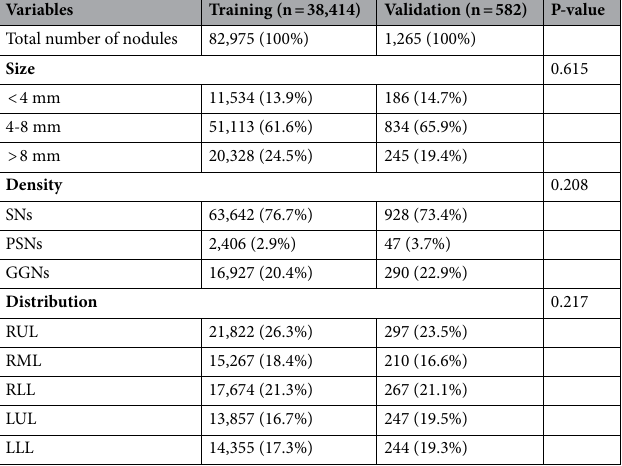
Table 2. The nodule description for training and validation set. SNs solid nodules, PSNs part-solid nodules, GGN ground glass nodules, RUL right upper lobe, RML right middle lobe, RLL right lower lobe, LUL left upper lobe, LLL left lower